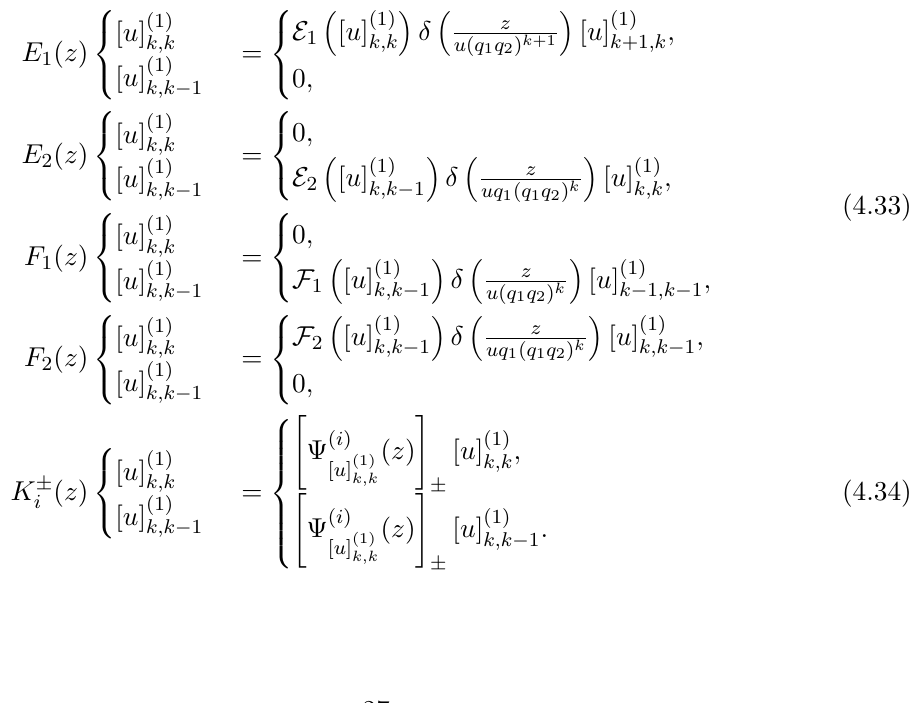
. (b) q j 1 2 has j + 1 j,j − 1